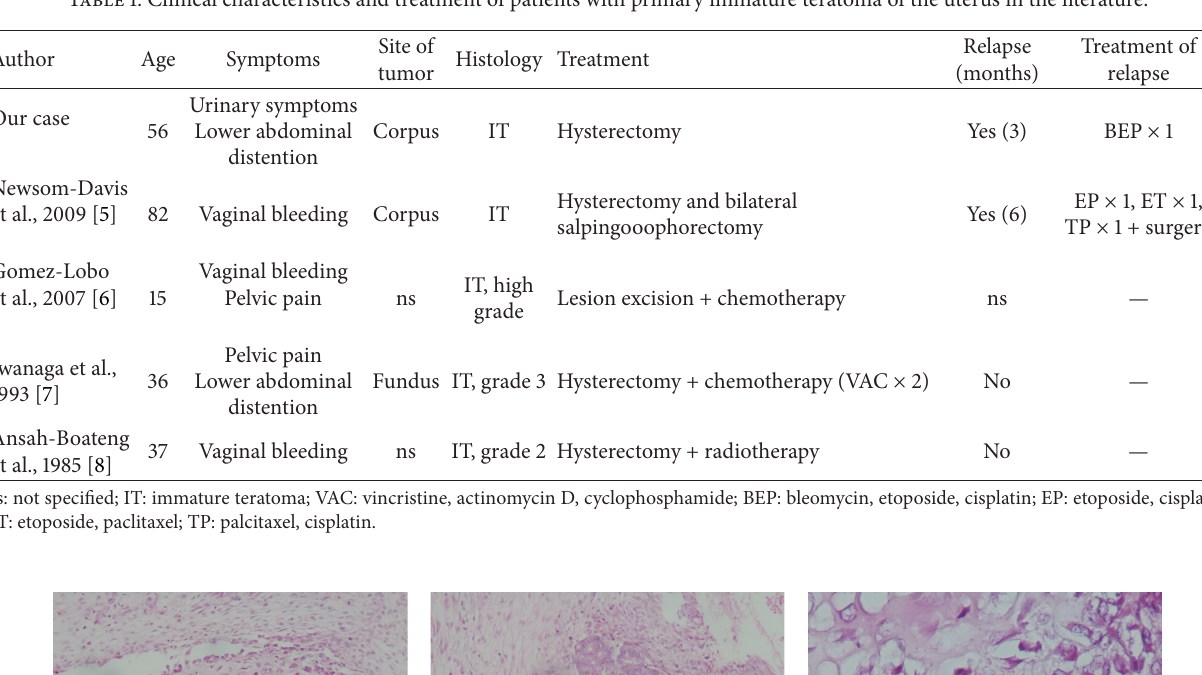
Table 1: Clinical characteristics and treatment of patients with primary immature teratoma of the uterus in the literature.